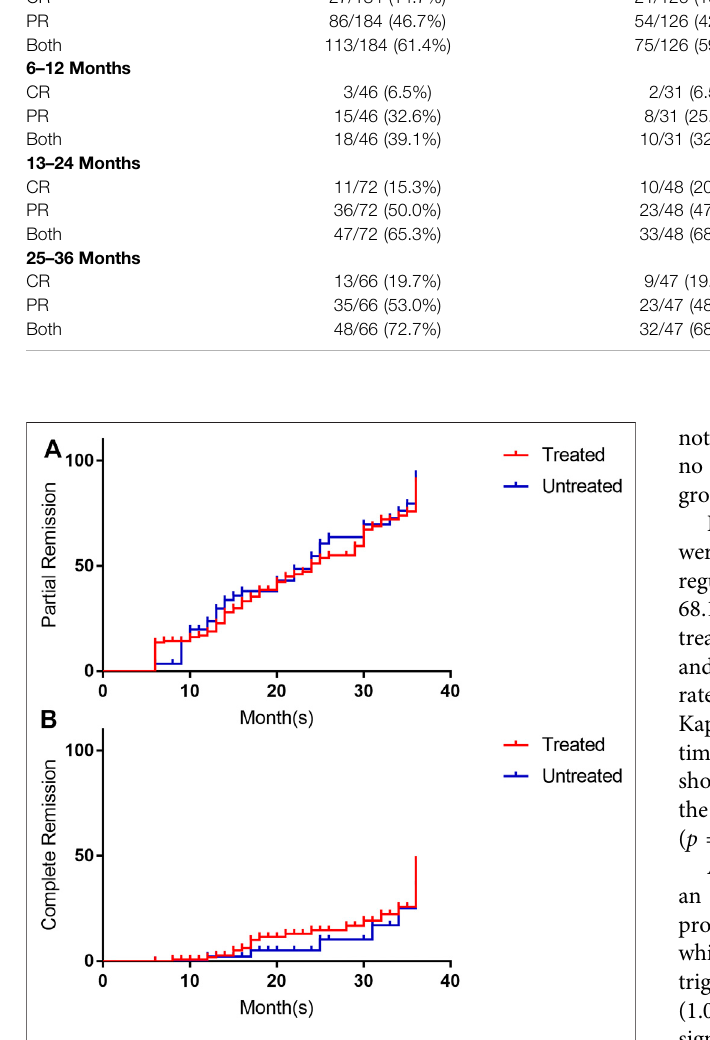
FIGURE2| Survivalanalysisofremissionrates(groupedbyprevioususe of immunosuppressive therapy). (A) is the survival analysis of partial response rate, and (B) is the survival analysis of complete response rate. The red line is treated with immunosuppressive, the blue line is un-treated with immunosuppressive. Its annotation is consistent with the grouping words in Table 1